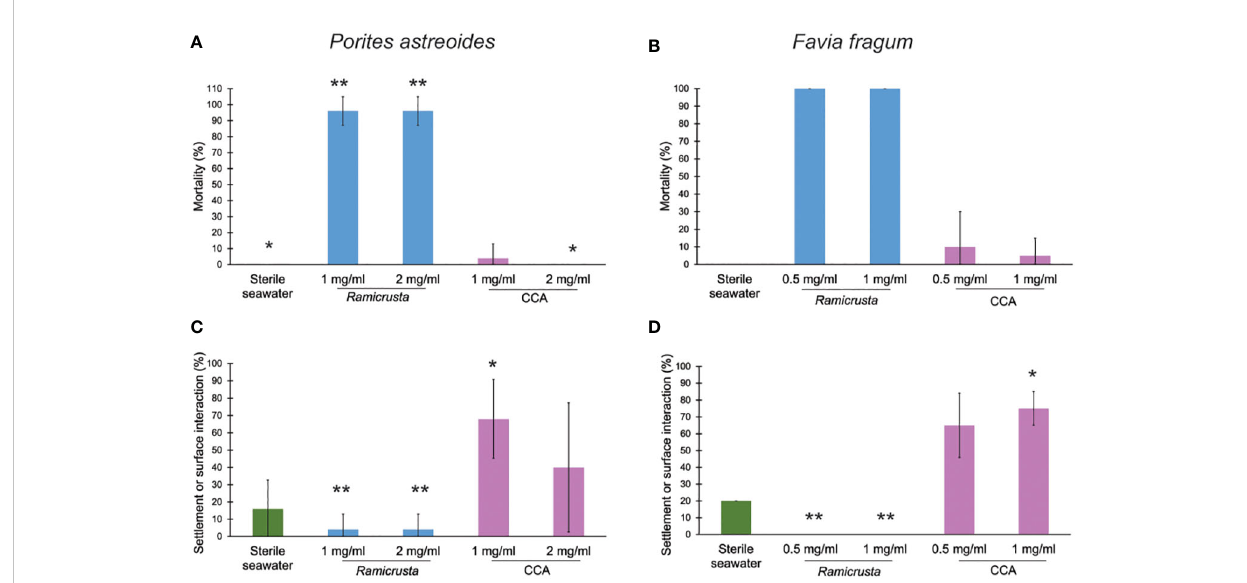
FIGURE 2 Ramicrusta exposure causes larval mortality and reduced settlement. The average percent (± SD) of P. astreoides (A) and F. fragum (B) larval mortality in the treatments (5 wells each containing 4-5 larvae) and percent of P. astreoides (C) and F. fragum (D) larvae that settled or interacted with the well surface (5 wells each containing 4-5 larvae). There was no mortality in the sterile seawater treatment of either experiment. Signi fi cantly different treatments according to Kruskal-Wallis H-test and Tukey Test post-hoc test are denoted by different asterisks groups (e.g., * and ** are signi fi cantly distinct) and are distinct for each fi gure panel (p <